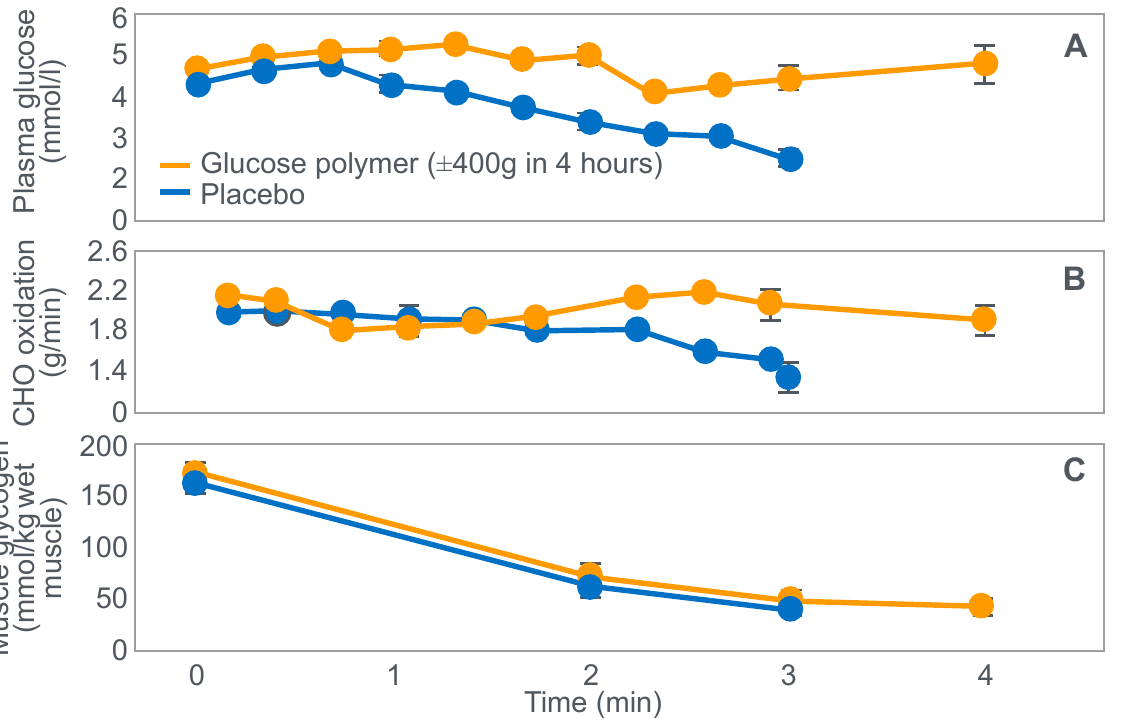
Figure 10. Changes in plasma glucose concentrations (panel A ), rates of carbohydrate (CHO) oxida- tion (panel B ) and muscle glycogen concentrations (panel C ) during prolonged exercise when subjects ingested either placebo or 100 g of carbohydrate every hour during exercise. Subjects began the trial after a 16 h fasting period. Adapted with permission from ref. [49]. Copy-right 1986 American Physiological Society.